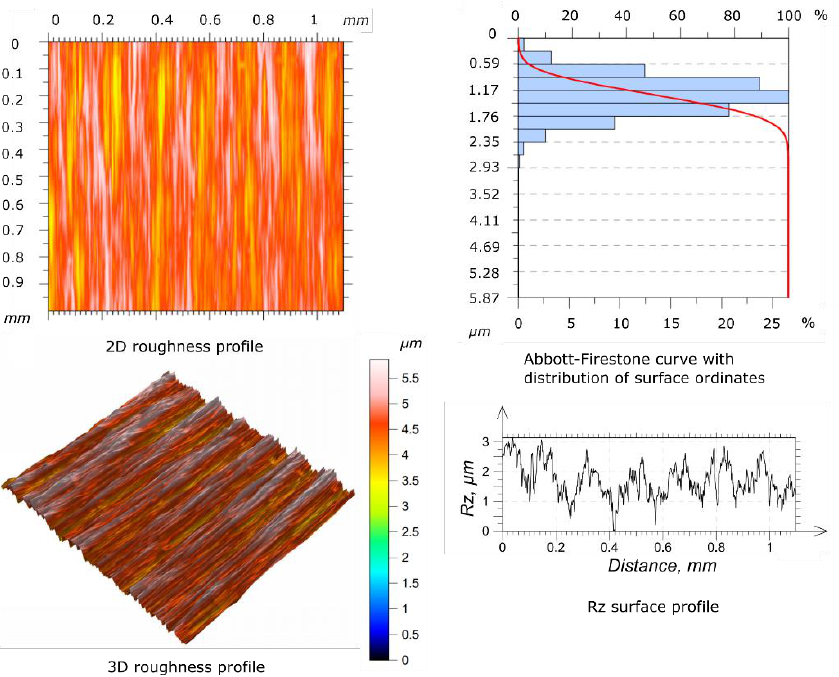
Figure 4. Geometric structure of the surface before the wear tests for counter-specimen. 190 The average parameters of surface roughness for the basic specimen and counter- 191 specimen before the wear tests are included in Table 2. 192 Table 2. Average roughness parameters of surfaces on the area of contact for specimen and counter- 193 specimen before the wear test.